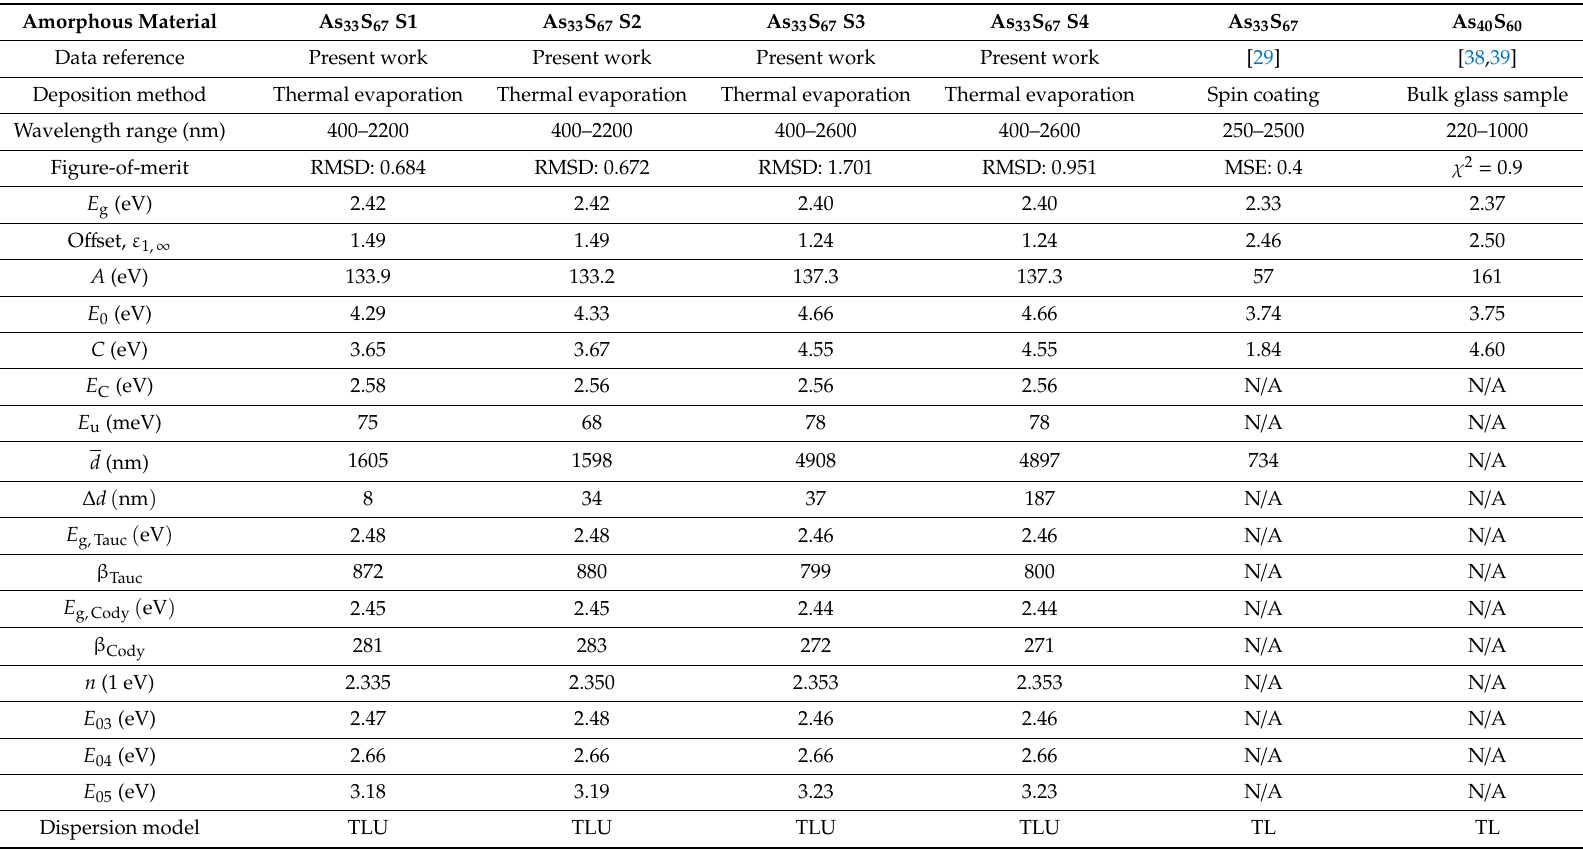
Table 2. The results of fitting four sets of optical data to the present TLU- oscillator model. The best-fit parameters E g , ε 1, ∞ , A , E 0 , C , and E c , are from the TLU-model parameterization. The values of the Urbach energy, E u , obtained from the previous TLU-model parameters, are indicated in the table. Besides, the values of the Tauc–Lorentz fitting parameters corresponding to an amorphous As 33 S 67 thin-layer sample deposited instead by spin coating, are also listed in this table for the sake of comparison. The Tauc–Lorentz parameters for the As 40 S 60 (As 2 S 3 , i.e., the stoichiometric-binary-composition) bulk glass, presented in the table, were reported by Jellison and